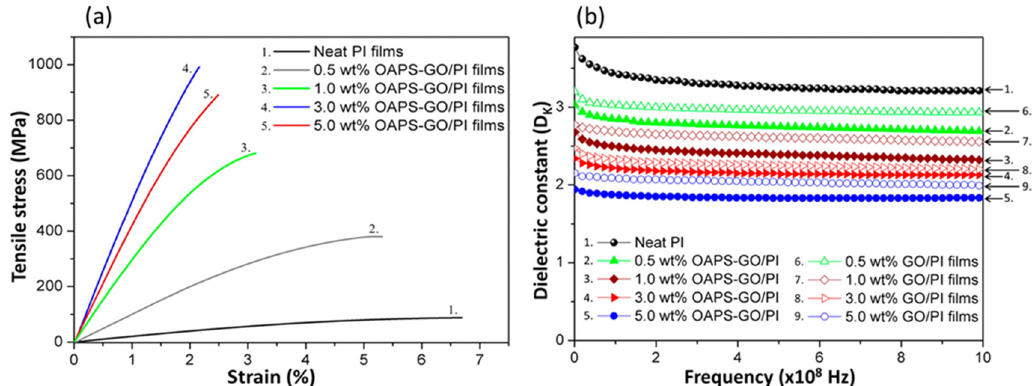
Figure 3. ( a ) Chemical structure of octa(aminophenyl)silsesquioxane (OAPS). ( b ) Schematic representation of the preparation of OAPS-graphene oxide (GO)/PI hybrid nanocomposites [74]. Reproduced with permission from the American Chemical Society.